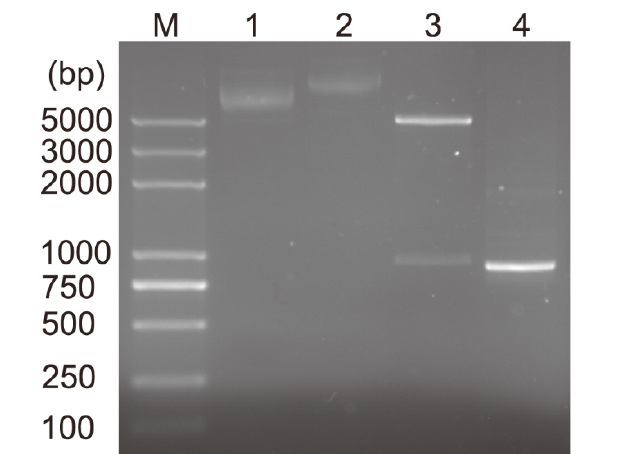
Fig 2 . Recombinant plasmid p GEX-6P-1 -SMPD validated by restriction enzyme Eco RI and Not I at agarose gel electrophoresis. M, molecular mass marker D2000; lane 1,p GEX-6P-1 empty plasmid; lane 2, p GEX-6P- 1 -SMPD recombinant plasmid; lane 3,p GEX-6P-1 -SMPD recombinant plasmid product cut by enzyme Eco RIand Not I; lane 4: SMPDPCR amplification product.